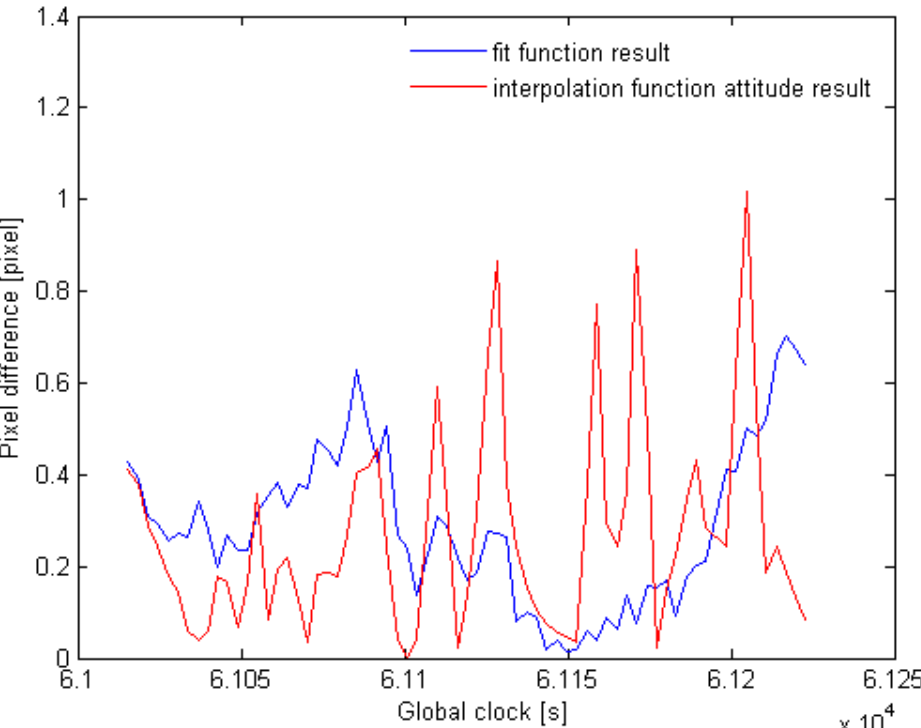
Figure 15. Image pixel estimation difference for different fitting algorithms.